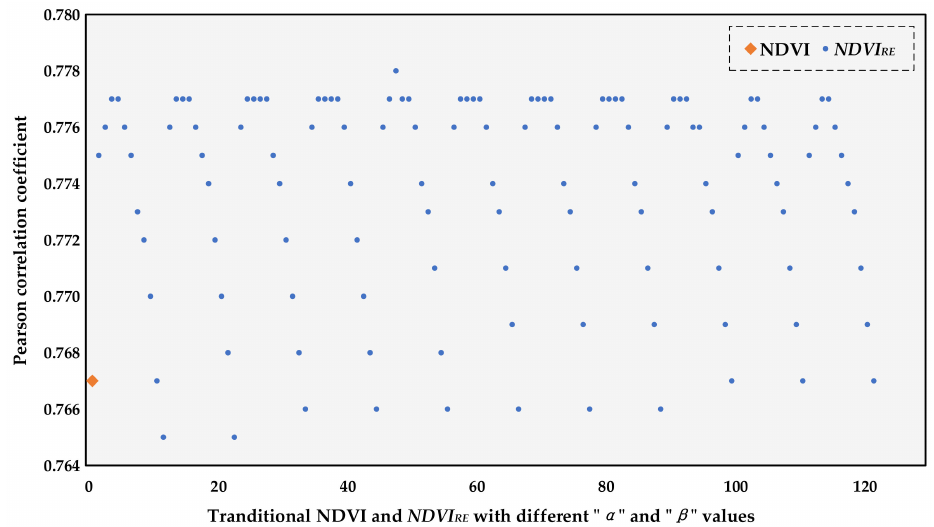
Figure 2. Pearson correlation coefficients of the NDVI and NDVI RE with FSV per unit